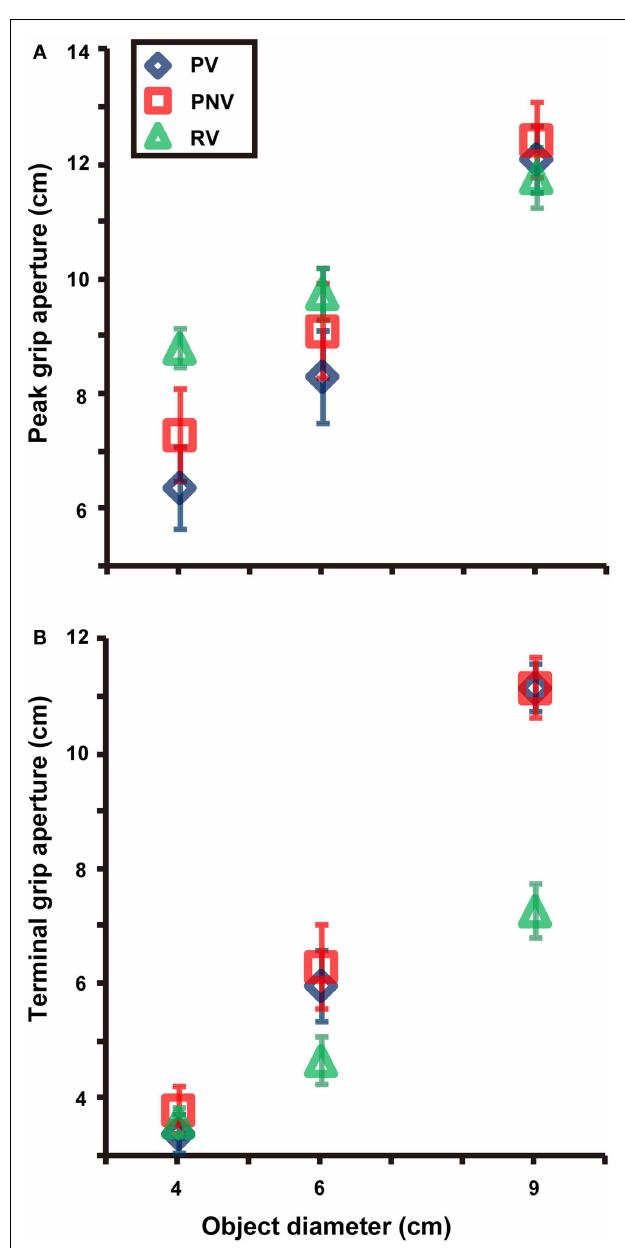
FIGURE 3 | Mean values of peak grip aperture (A) and terminal grip aperture (B) in each condition. Differences between PV and PNV conditions for the 4 and 6-cm objects were found, whereas no difference of terminal grip aperture was noted between the PV and PNV conditions for any object size. PV, PNV, and RV indicate pantomime prehension with vision, pantomime prehension without vision, and real prehension with vision, respectively. Error bars indicate the standard errors of the values between